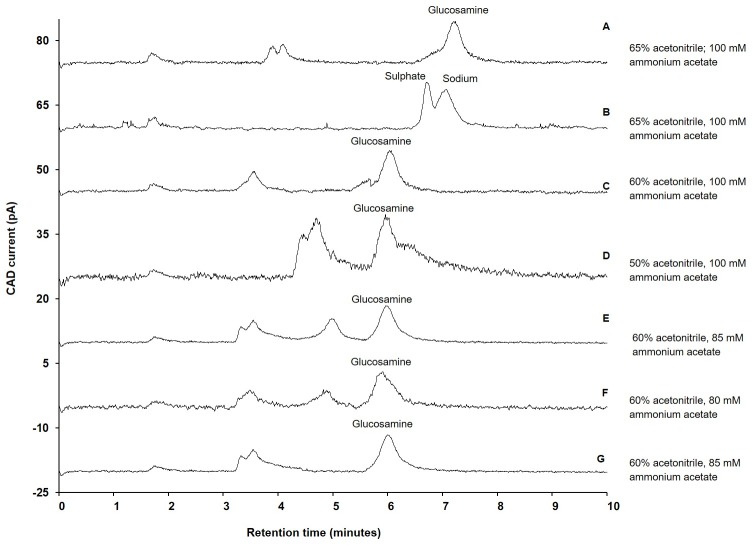
Influence of various composition of acetonitrile and ammonium acetate on separation of glucosamine.A) Separation of glucosamine sulphate when mobile phase contain 65% acetonitrile and 100 mM ammonium acetate; B) Separation of sodium sulphate when mobile phase contain 65% acetonitrile and 100 mM ammonium; C) Separation of glucosamine sulphate when mobile phase contain 60% acetonitrile and 100 mM ammonium acetate; Inset-1: Separation of glucosamine sulphate when mobile phase contain 50% acetonitrile and 100 mM ammonium acetate; D) Separation of glucosamine sulphate when mobile phase contained 50% acetonitrile and 100mM ammonium acetate; E) Separation of glucosamine sulphate when mobile phase contain 60% acetonitrile and 85 mM ammonium acetate; F) Separation of glucosamine sulphate when mobile phase contain 60% acetonitrile and 80 mM ammonium acetate; G) Separation of glucosamine hydrochloride when mobile phase contain 60% acetonitrile and 85 mM ammonium acetate; Experimental conditions: ZIC-HILIC column (150, 4.6 mm), 200 Å, 5 μm; mobile phase containing various composition of acetonitrile (as specified above) and ammonium acetate (as specified above); column temperature 40°C; detection with Corona-CAD; flow rate 0.3 mL/minute; injection volume 5 μL.